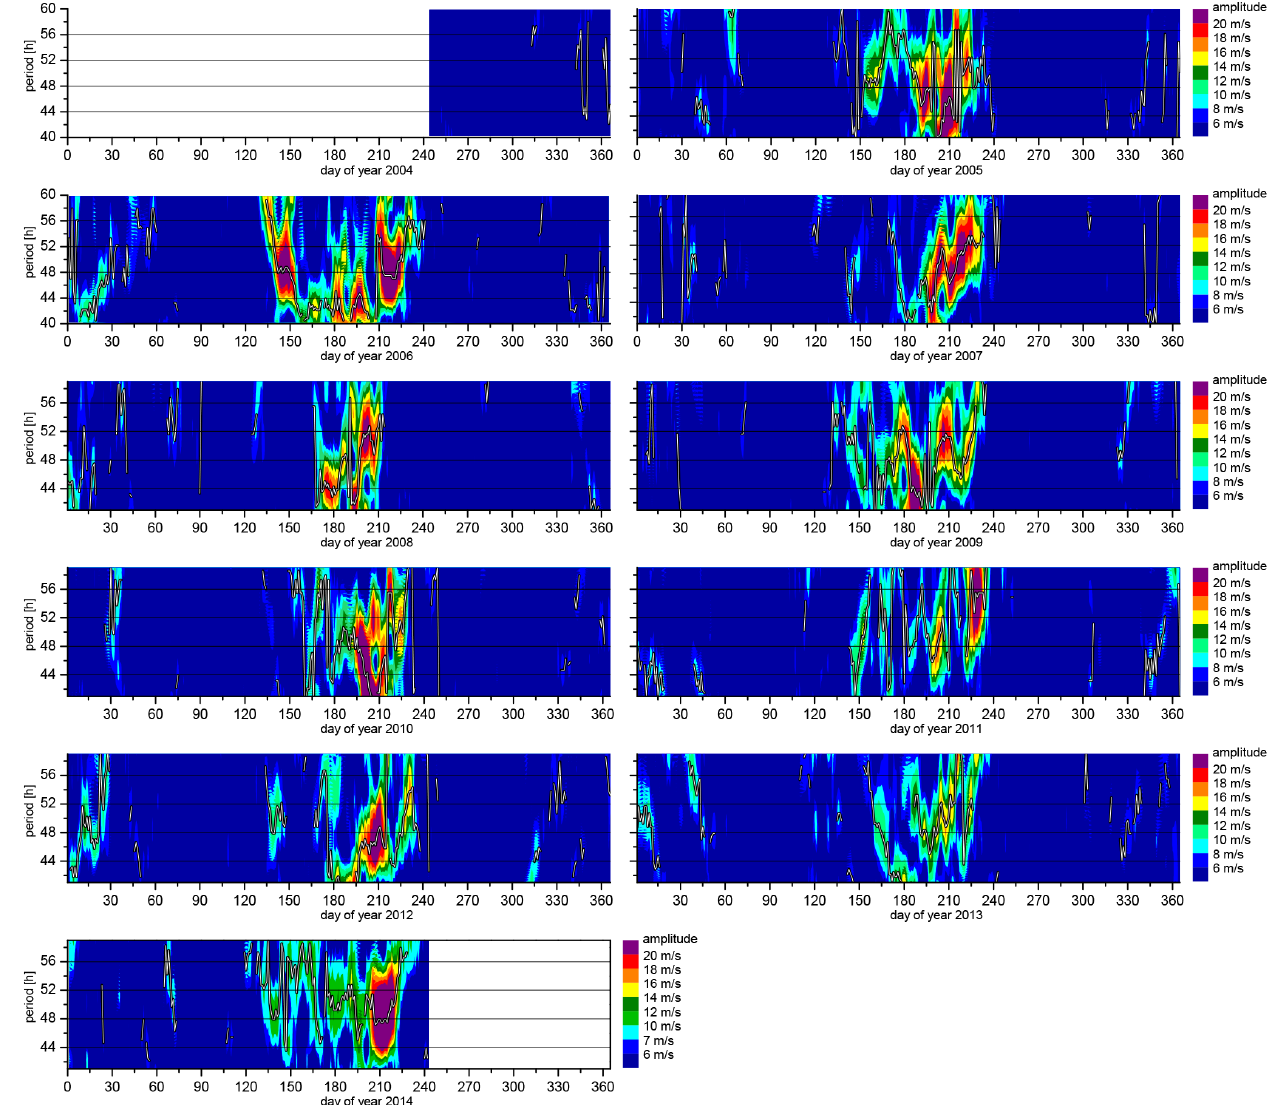
Figure 3. Periodograms of the meridional amplitude for the years 2004–2014 at 91km altitude. Each day represents the center of an 11-day analysis of horizontal wind data. The white line follows the period of maximum amplitude between 40 and 60h if amplitudes are larger than 6ms − 1